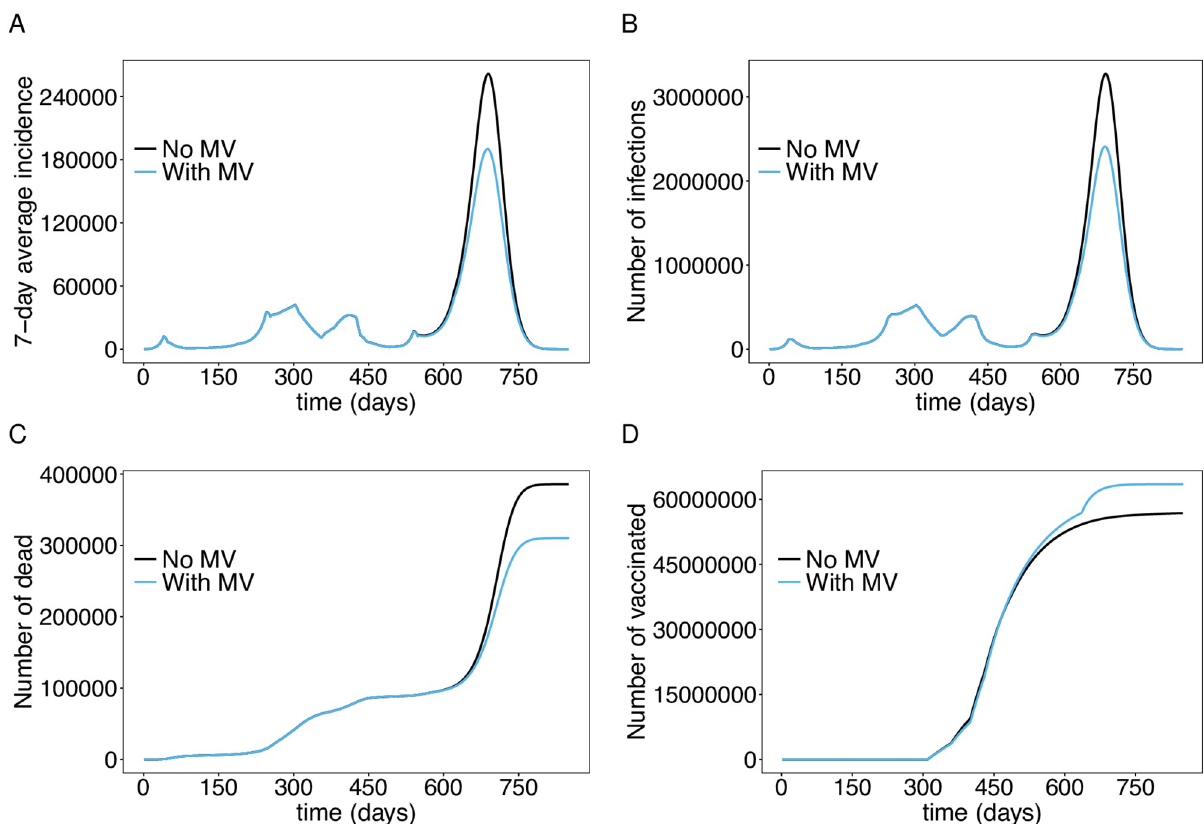
Fig 7. Effect of mandatory vaccination (MV). Shown are the 7-day average incidence (A) and total numbers of infected individuals (B) with and without mandatory vaccination of individuals older than 12 years of age after November 22, 2021, assuming a continuation of the interventions of November 2021. Further shown are the corresponding numbers of deaths (C) and vaccinated individuals (D). The parameters used for the simulations are listed in S1 to S11 Tables.